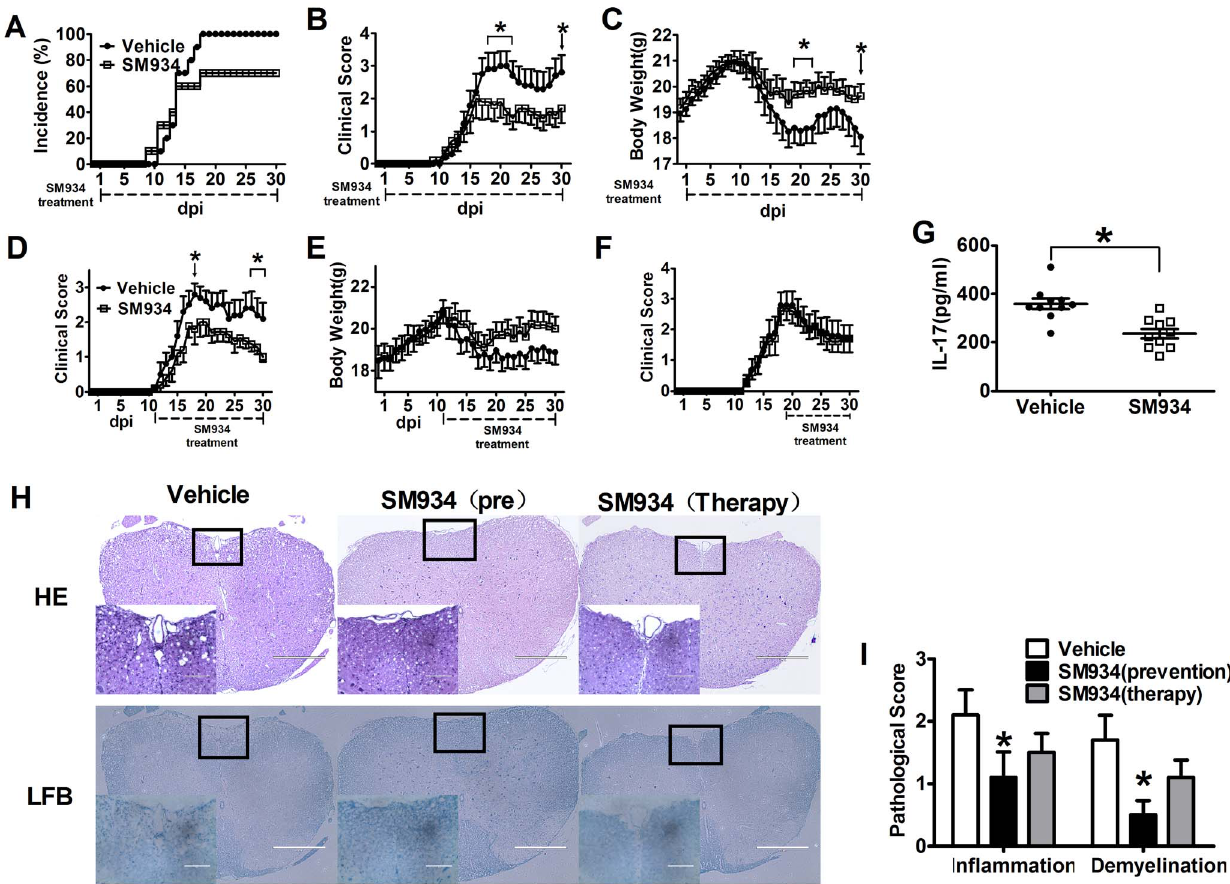
Figure 1. SM934 treatment inhibited the development of EAE in MOG-immunized C57BL/6 mice. Active EAE was induced in female C57BL/6 mice by immunization with MOG 35 2 55 . The mice were orally treated with vehicle or SM934 (10 mg/kg/day) from day 1 post-immunization as detailed under Materials and methods. Mice were monitored for signs of EAE, and the results for all mice, both healthy and sick, were presented as (A) incidence of disease, (B) mean clinical score 6 SEM, and (C) body weight. Immunized mice were treated with vehicle or SM934 (10 mg/kg/day) from day 11 post-immunization, and the clinical score (D) and body weight (E) were monitored. Immunized mice were treated with vehicle or SM934 (10 mg/kg/day) from day 18 post-immunization, and the clinical score (F) were monitored. (G) Serum from both groups of mice were collected at the peak of disease (day 18 p.i.), and measured IL-17 level by ELISA, each dot represents one mouse. n = 10 in each group. (H) Spinal cords were collected from EAE mice treated with vehicle or SM934, treated from day 1 p.i. (pre) or treated from day 11 p.i. (therapy). The sections were stained with H&E and Luxol fast blue to assess inflammation and demyelination. (I) Pathological scores including inflammation and demyelination were analyzed and shown with bar graph. Results were expressed as mean 6 SEM. *, p , 0.05, compared with vehicle control. Three independent experiments were performed with similar results.